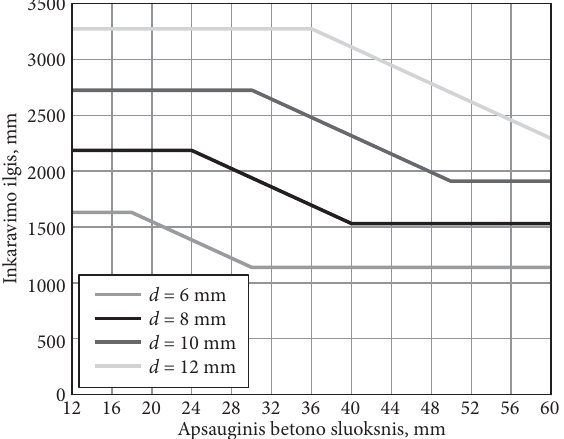
Fig. 5. Eff ect of carbon fi ber reinfoced polymer (CFRP) bar diameter on reinforcement anchorage length